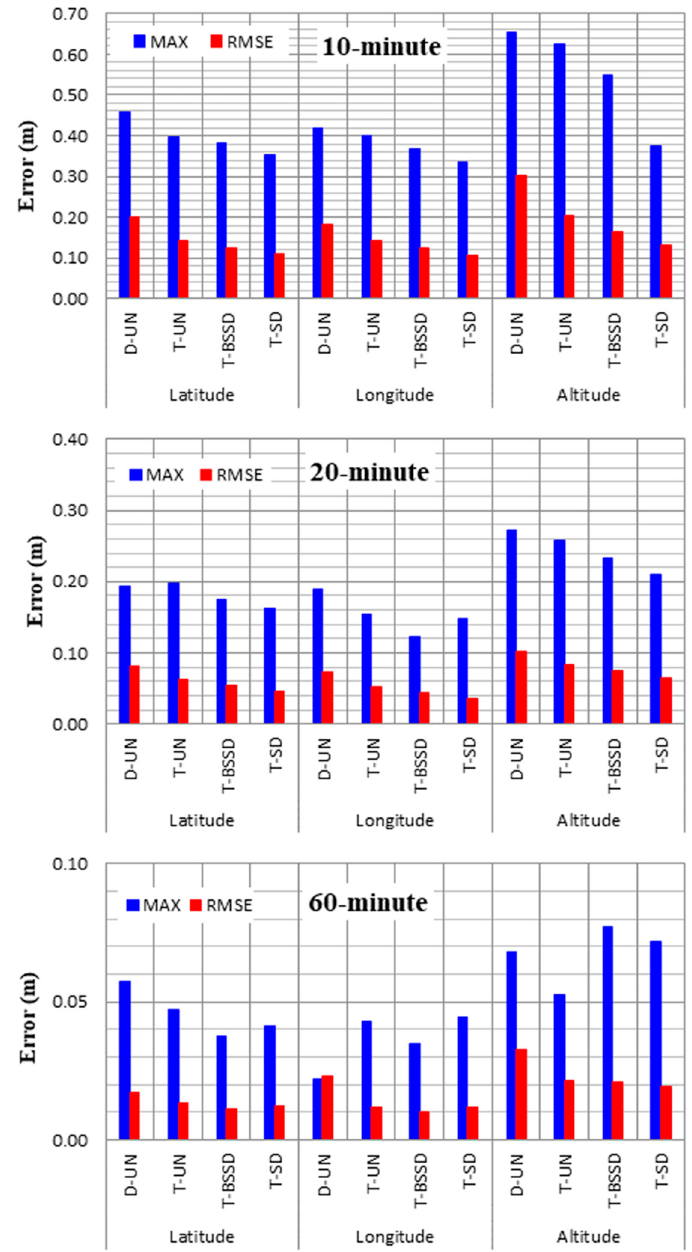
Figure 7. Maximum and RMSE values of the estimated positioning errors from the PPP solutions. Figure 7. Distribution of the examined